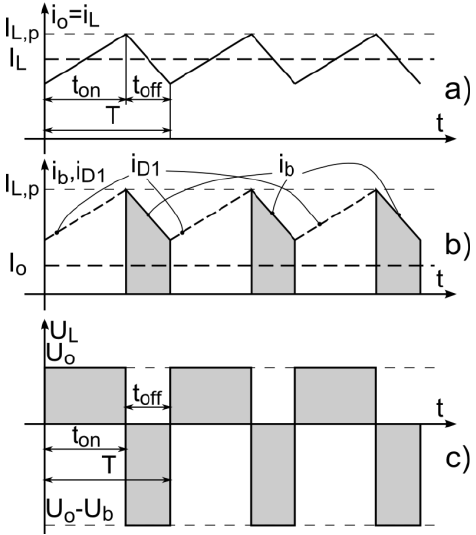
Figure 6. Layout 2 charge operation: current and voltage waveforms (continuous conduction).